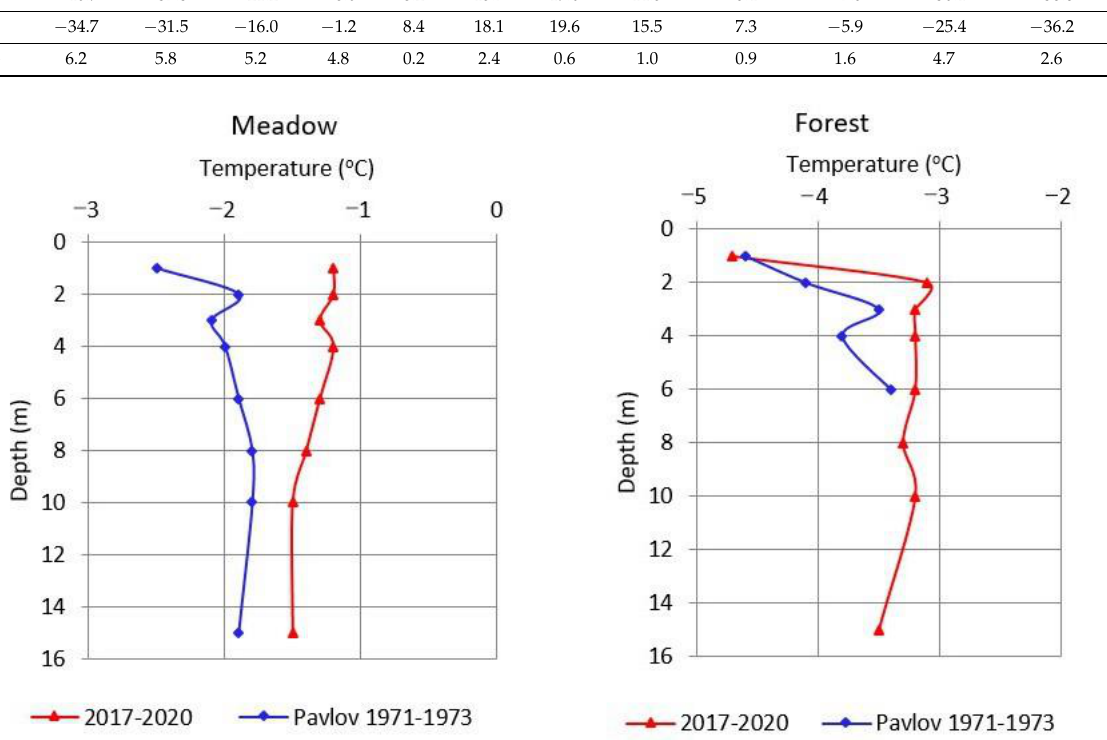
Figure 10. Change in depth of the mean annual ground temperature in the meadow and in the forest for different periods at the Tuymaada Station.